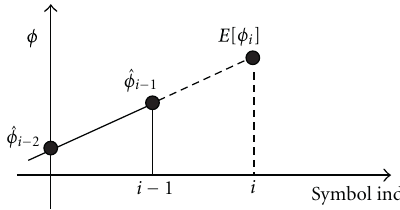
Figure 4: Estimation of timing o ff set during the packet